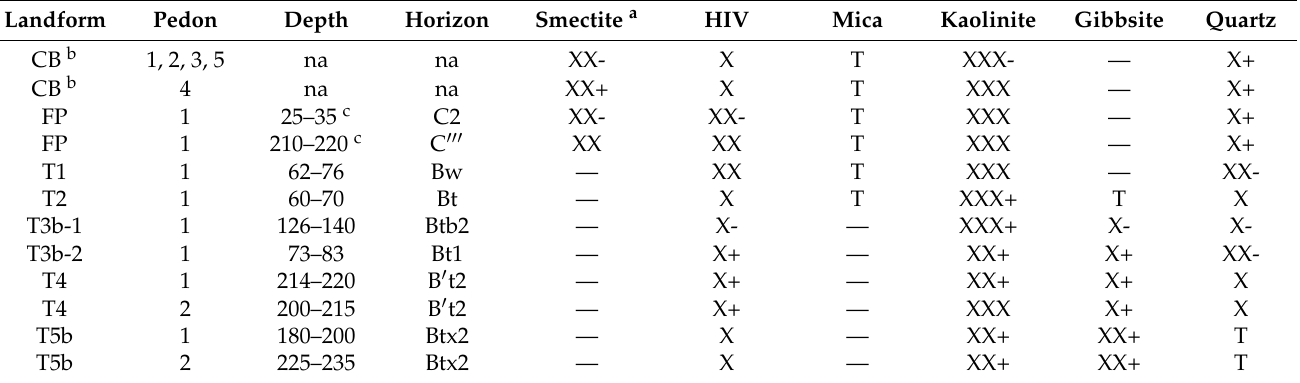
Table 4. Relative abundance estimates of clay fraction (<2 µ m) minerals for channel bed sediment and the most well-expressed part of the most well-developed subsoil horizon of at least one representative pedon per landform along the Little